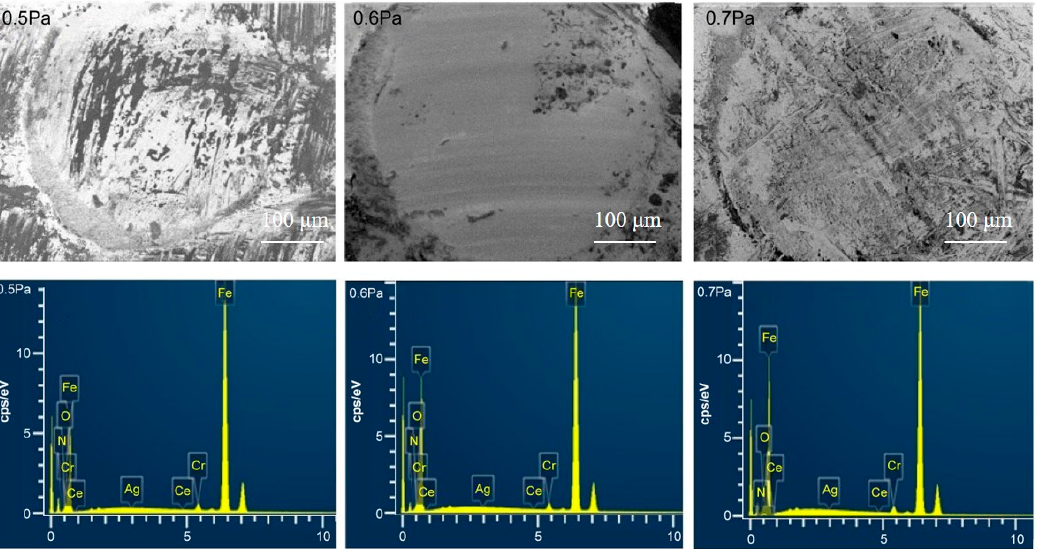
Figure 7. SEM images of the counter-face material (GCr15) after wear testing of coatings deposited at different pressures (left to right: 0.5, 0.6 and 0.7 Pa) under a 3-N normal load.